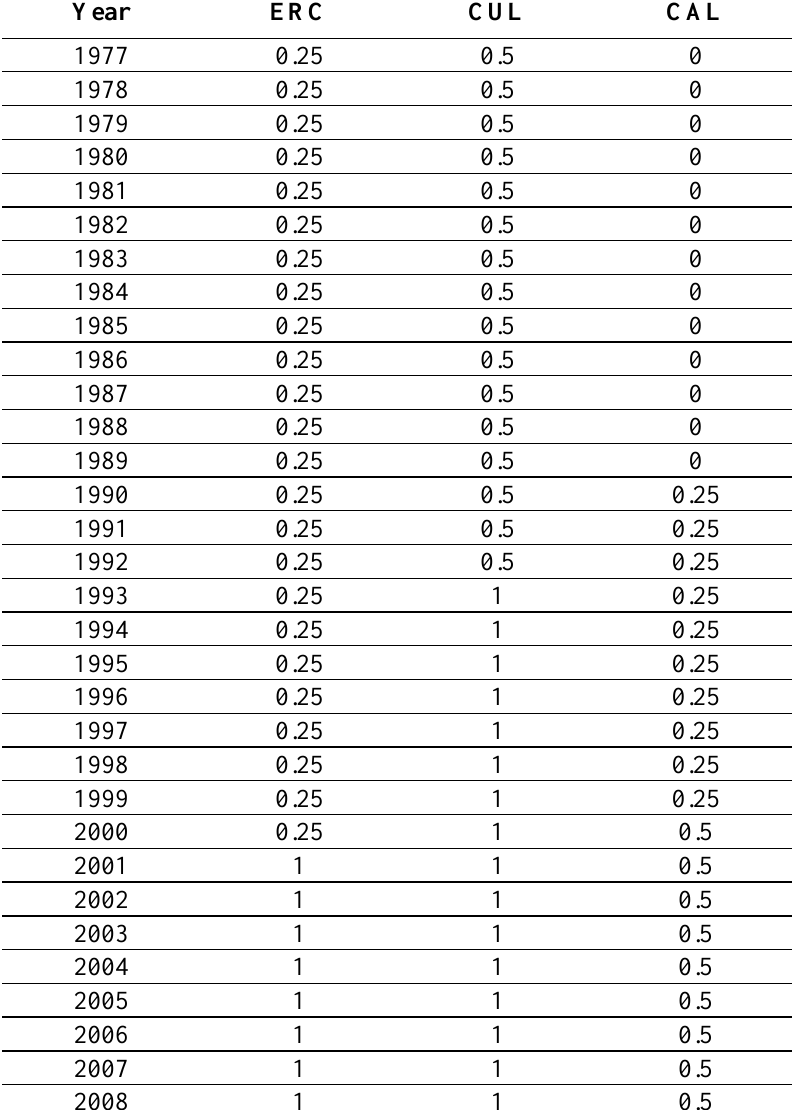
Table 4: Liberalization of the External Sector – Scores